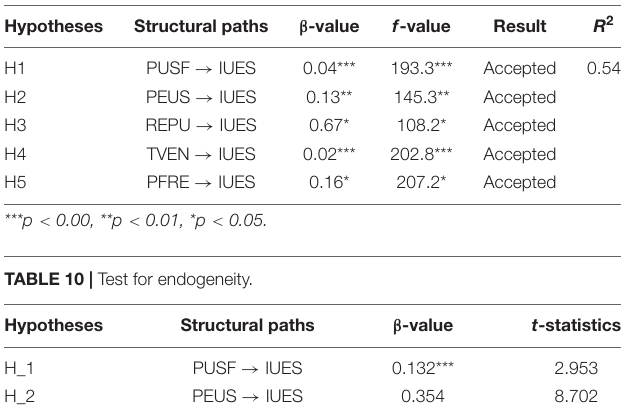
TABLE 9 | Result hypothesis testing.